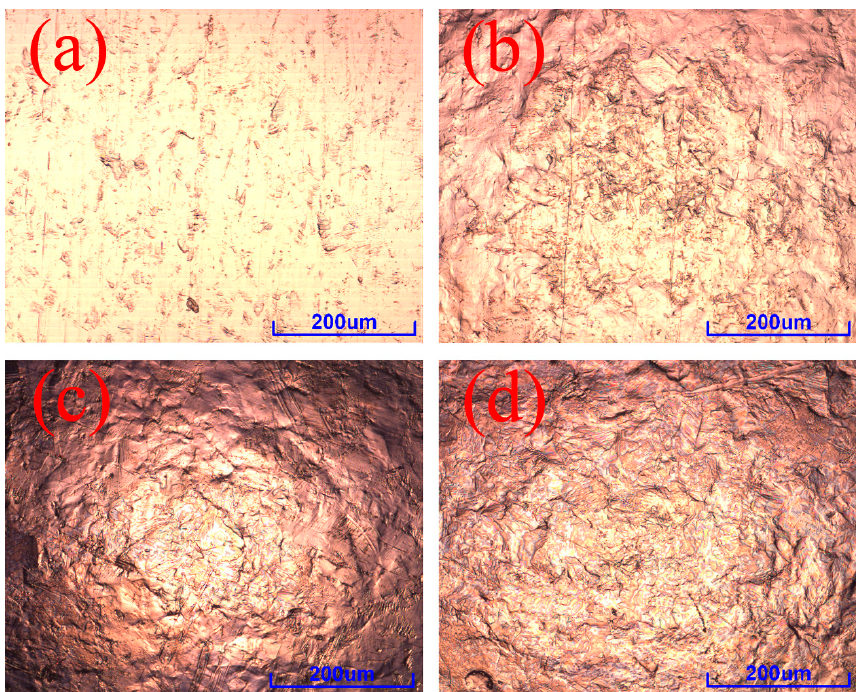
Figure 10. Surface morphology of nickel layer: (a ) initial portion; ( b ) bottom portion formed through mold 1; ( c ) bottom portion formed through mold 3; ( d ) bottom portion formed through mold 5.